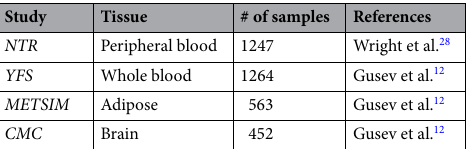
Table 1. Resources of the four eQTL—derived weights used in the simulation